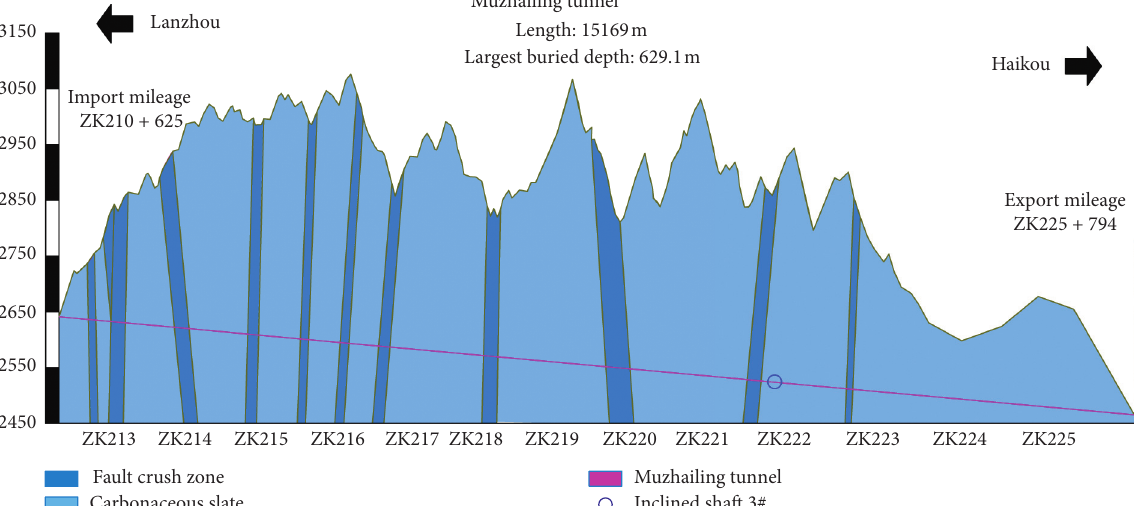
Figure 2: Stratigraphic condition of Muzhailing tunnel.